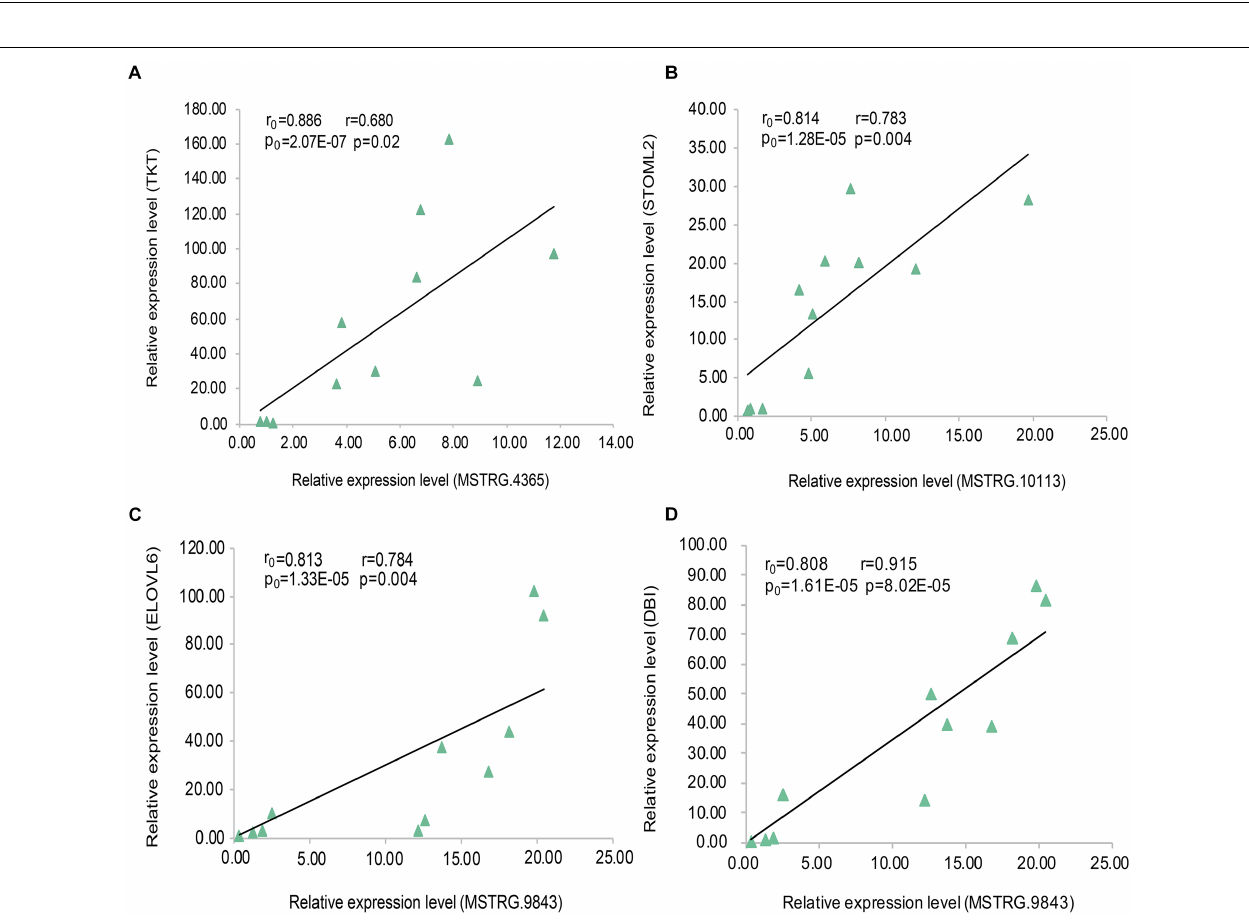
FIGURE 7 | Linear regression of lincRNA and PTG expression. The r 0 and p 0 represent the Pearson correlation coefficient and P -value of each pair of lincRNA and PTG in 20 samples,respectively;The r and p represent verification in 11 samples. (A) MSTRG.4365 vs. TKT; (B) MSTRG.10113 vs. STOML2; (C) MSTRG.9843 vs. ELOVL6; (D) MSTRG.9843 vs.